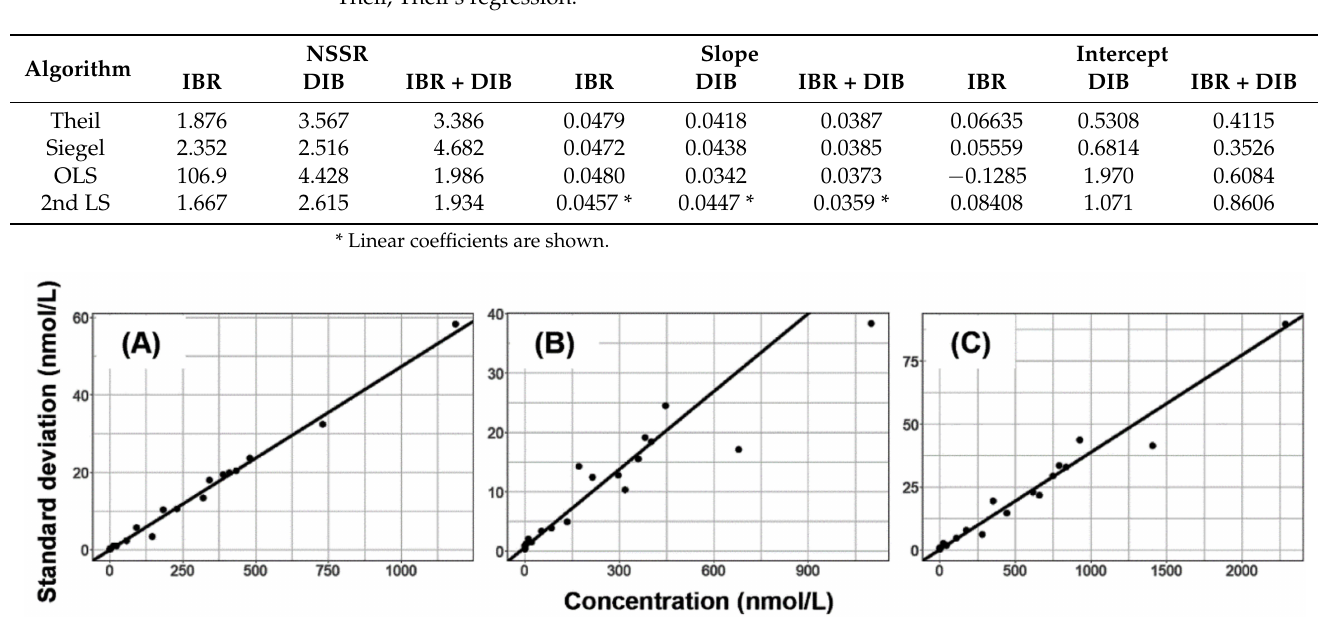
Figure 3. Linear regression applied to the concentration–standard deviation relationships using Theil’s regression with the Siegel estimator. ( A ) Ibrutinib (standard deviation = 0.04721 × concentra- tion + 0.05559. ( B ) Dihydrodiol ibrutinib (standard deviation = 0.04382 × concentration + 0.6814). ( C ) Active moiety (standard deviation = 0.03854 × sum of IBR + DIB concentrations +